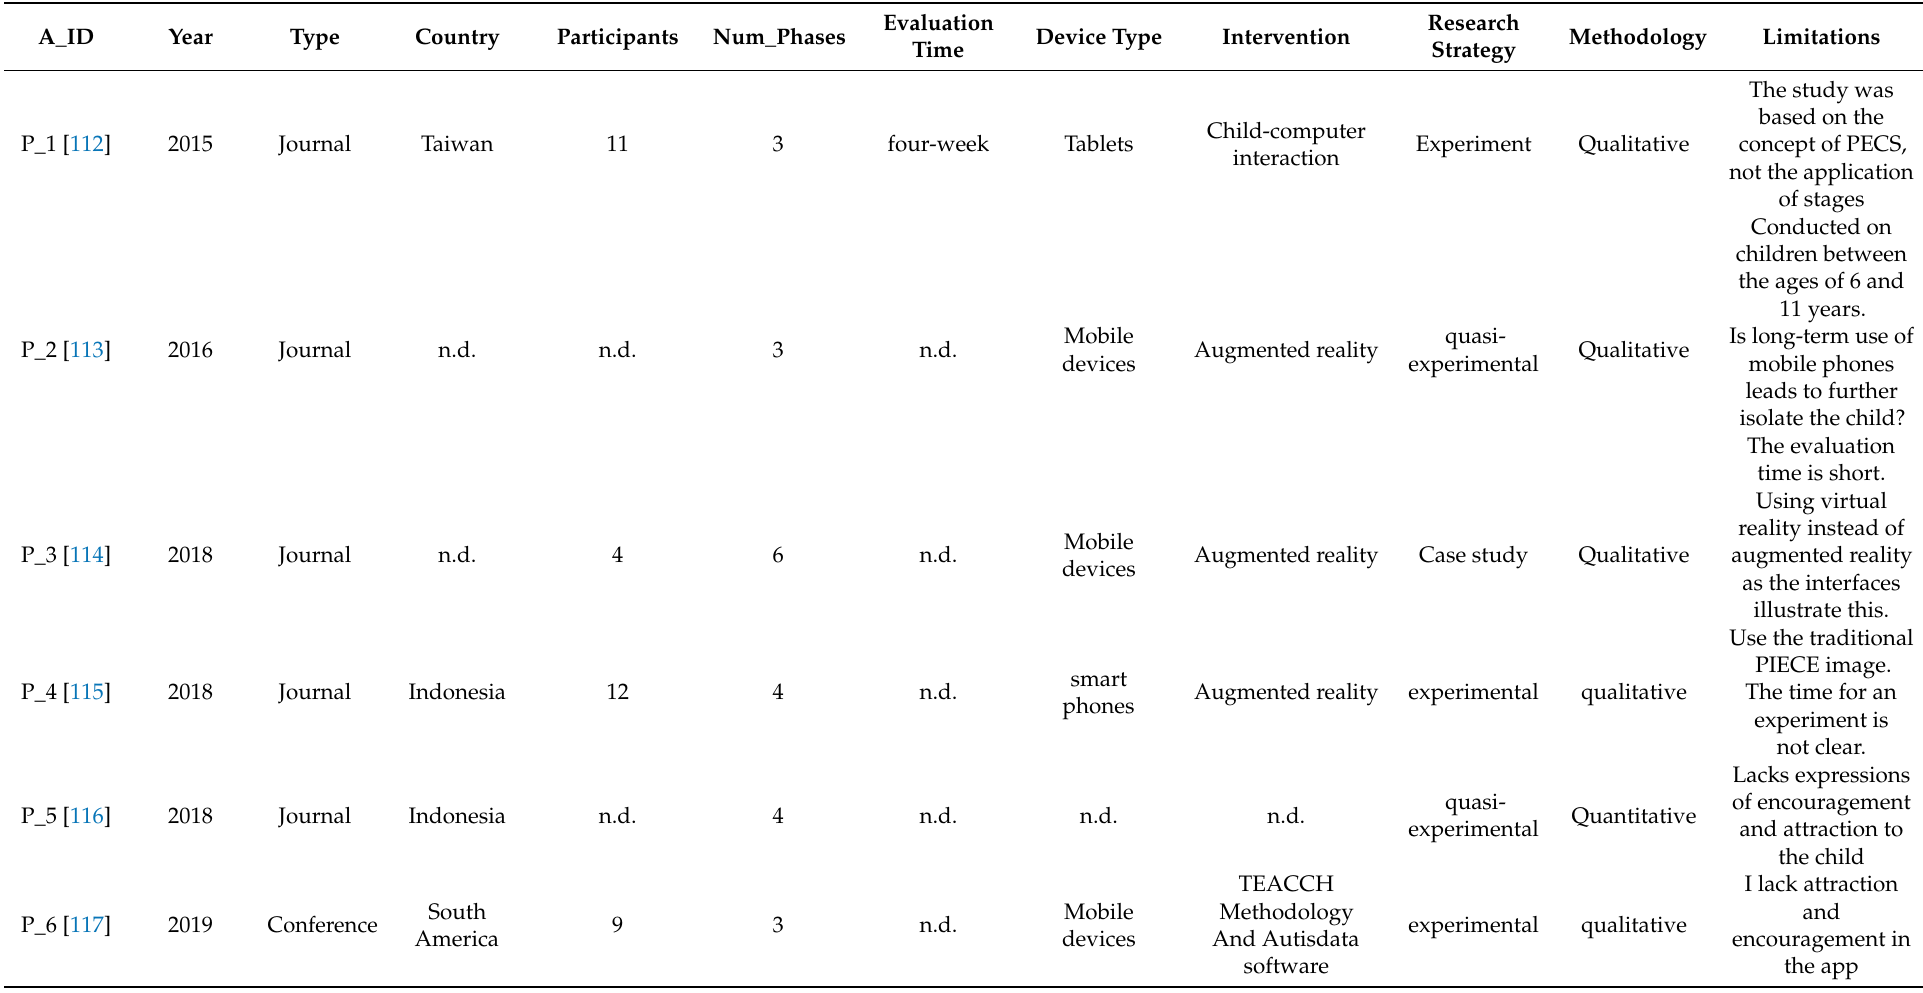
Table 10. The related studies of PECS applications with